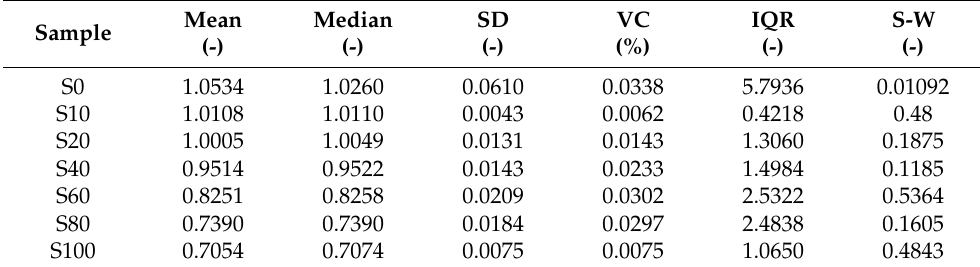
Figure 5. The dependence of the apparent viscosity on the time (samples: S0, S10, S40, S60).